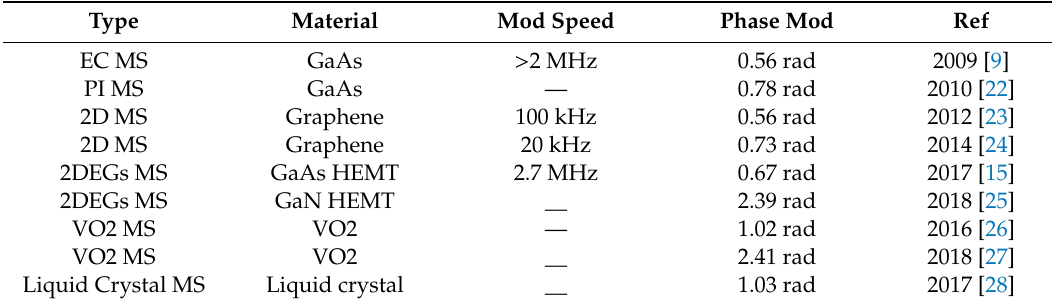
Table 2. THz phase modulator type, materials, and basic